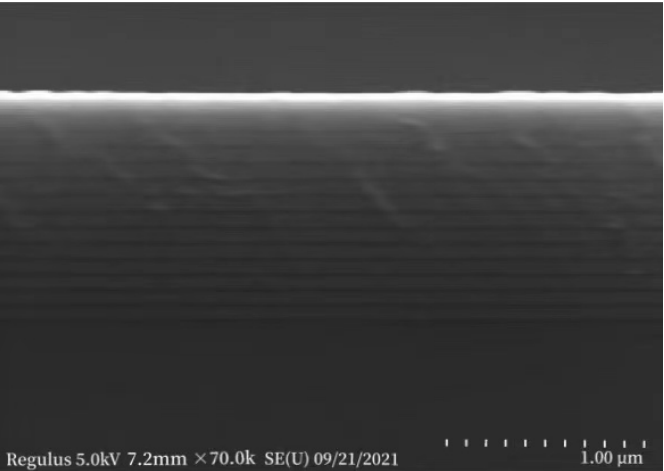
Figure 7. Multilayer thin-film SEM spectroscopy.